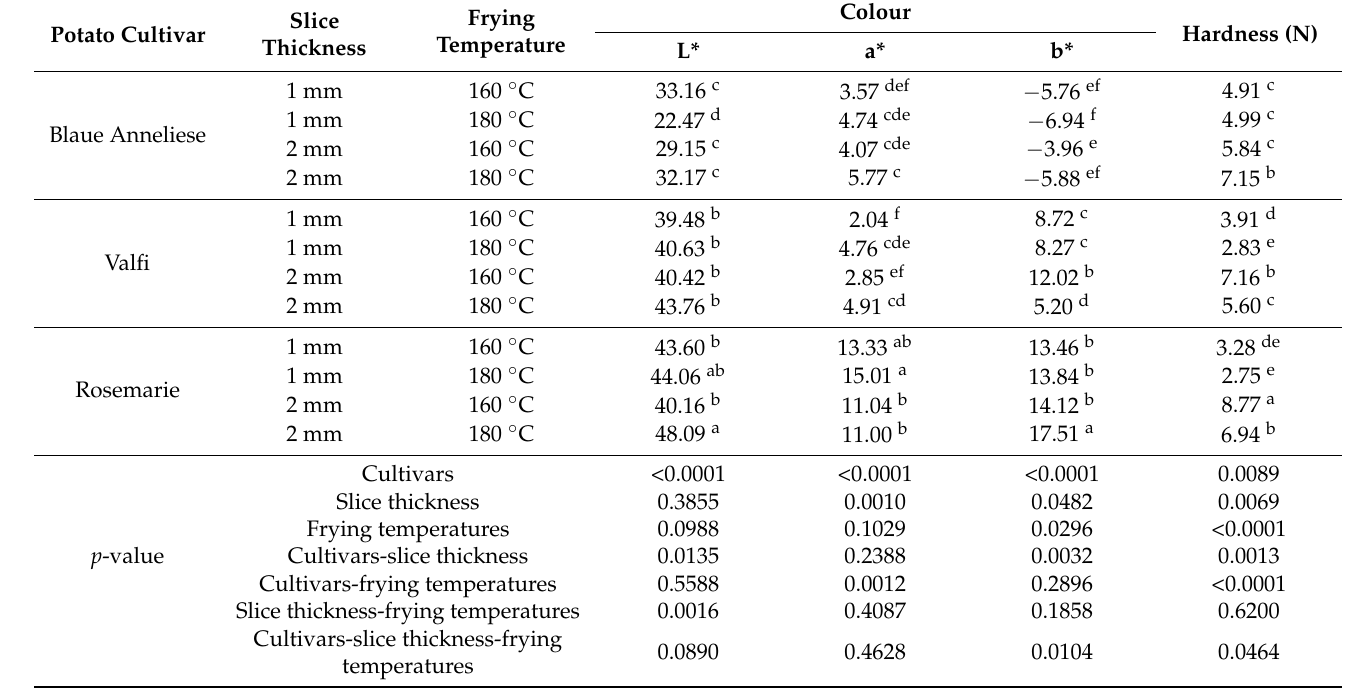
Table 4. The influence of cultivar, slice thickness and frying temperature on the colour characteristics and hardness of the chips produced from coloured potato